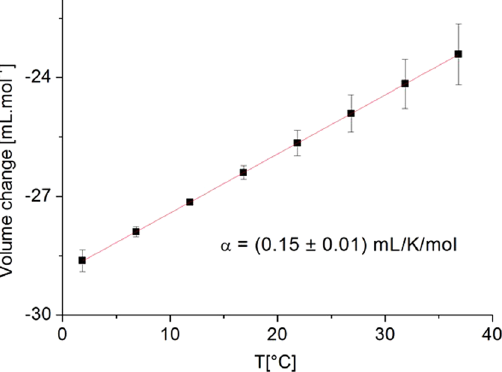
Figure 5. Volume change extracted for DMPC at 25 mol% of cholesterol. The line is a linear fit to the data in order to extract α = ∂Δ